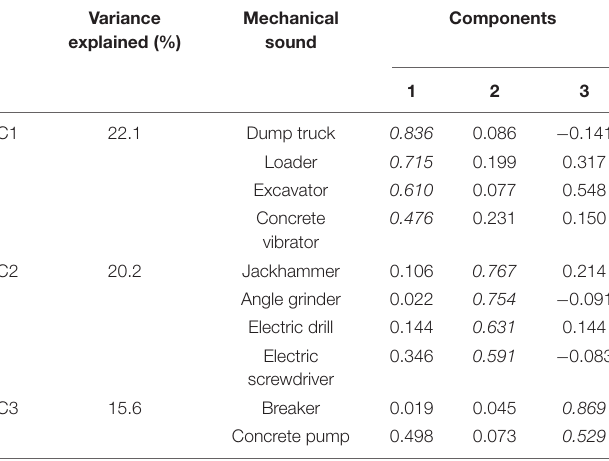
TABLE 9 | Results of principal components analysis showing the classification results of ten typical noises. Variance explained (%)